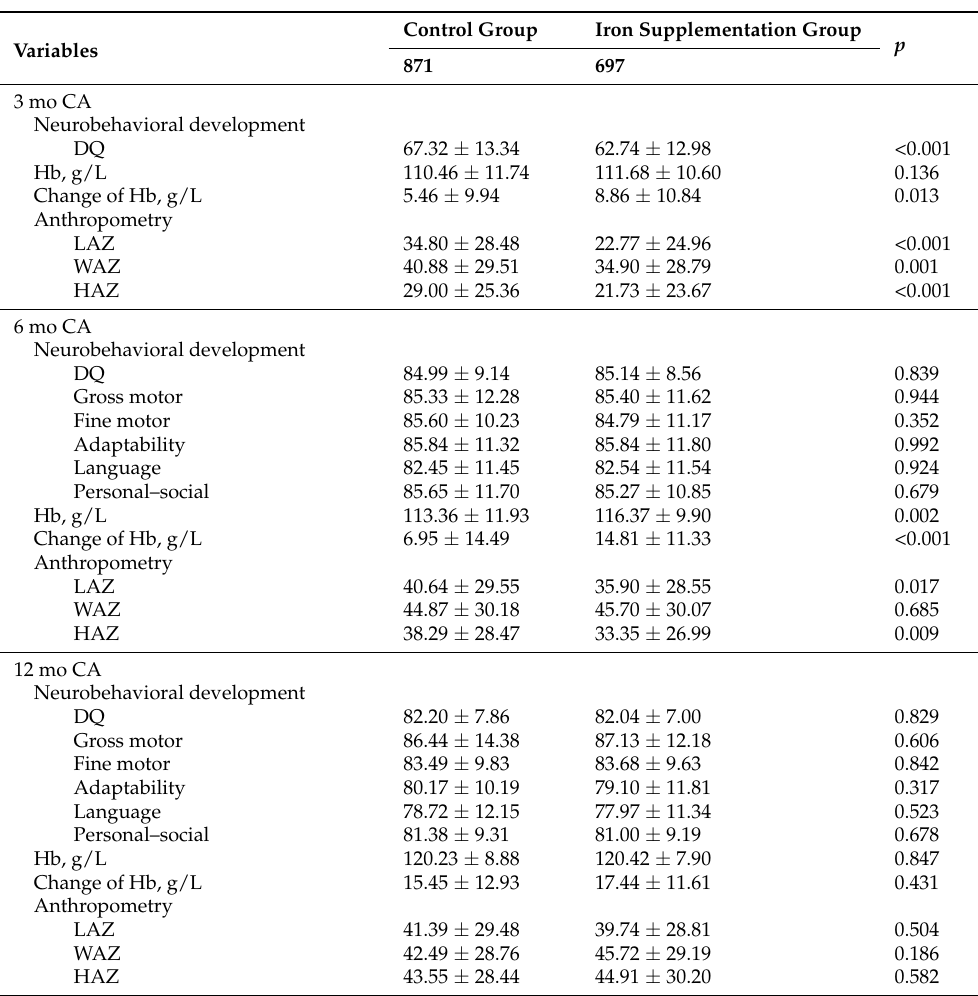
Table 2. Difference in neurobehavioral development, Hb, and anthropometry between the control group and iron supplementation group at 3, 6, and 12